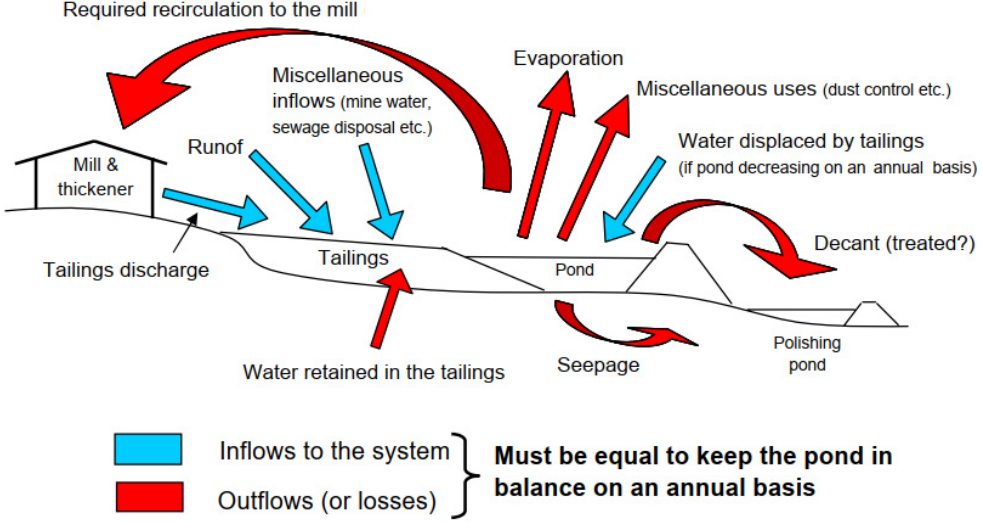
Figure 4. Typical Flows into and out of a mine tailings disposal facility.